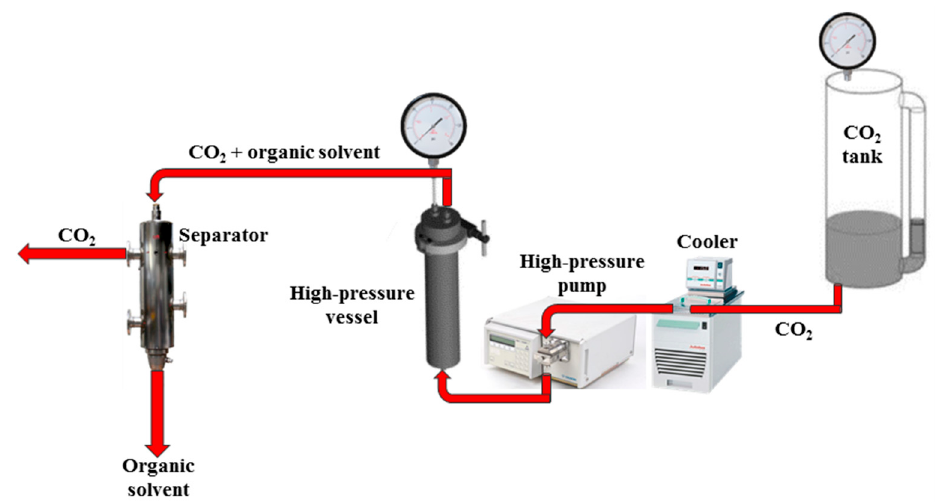
Figure 9. Schematic representation of the plant layout used for SC ‐ CO 2 drying.